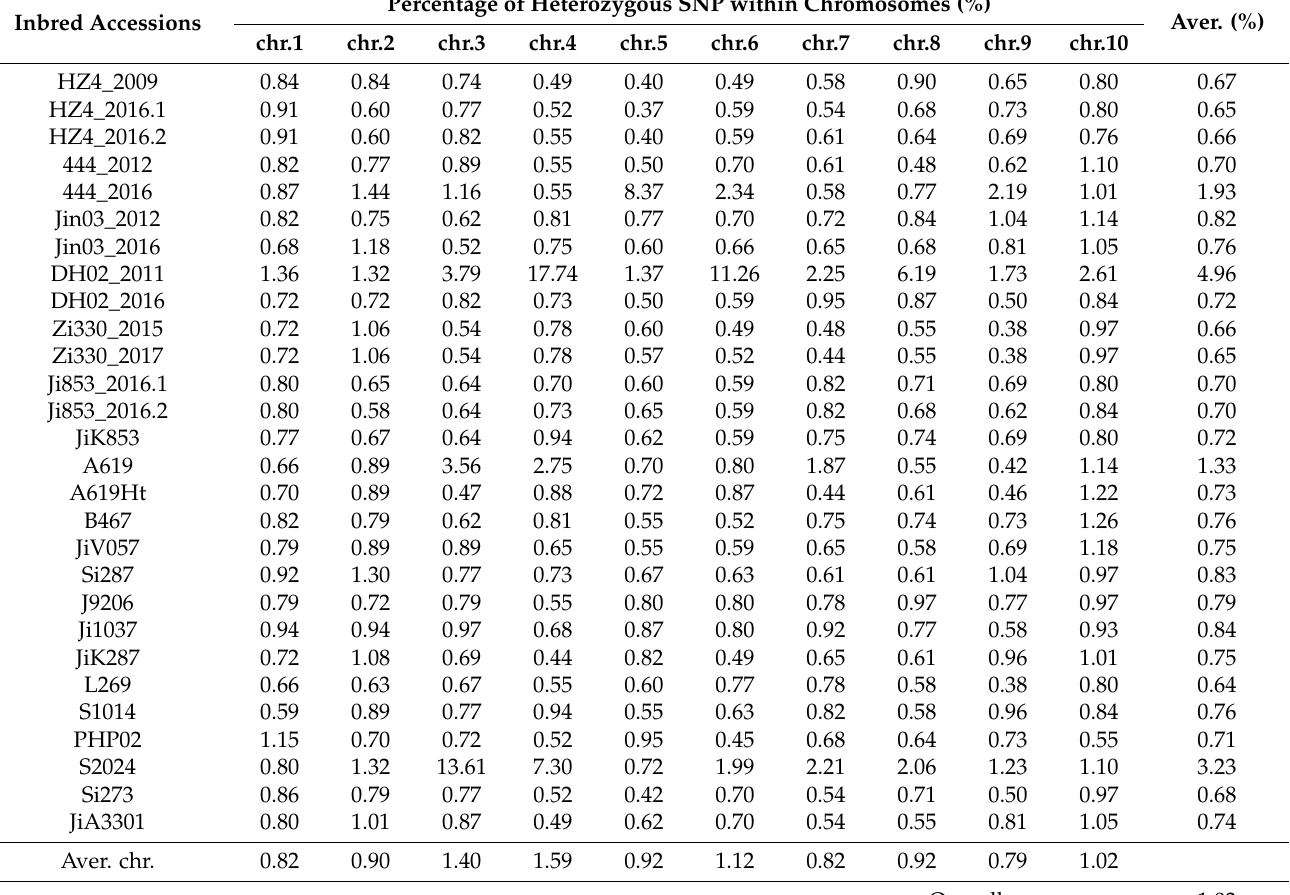
Table 1. Estimation of overall and single-chromosomal genome residual heterozygosity levels among maize inbred accessions using genome-wide SNP genotypes. Percentage of Heterozygous SNP within Chromosomes (%) Inbred Accessions